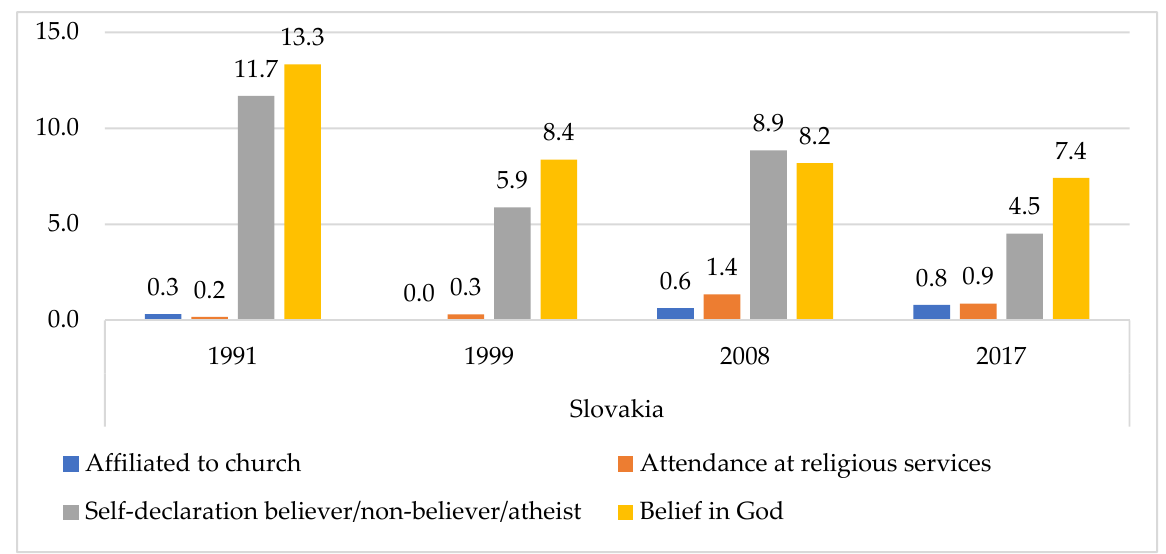
Figure 2. Overview of indicators of religiosity for which no answers were gathered from respondents (%).